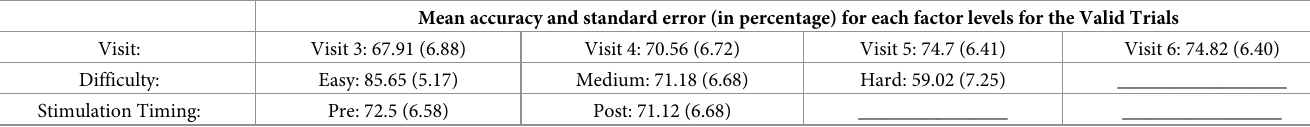
Table 4. Summary of mean accuracy and standard error for the significant main effects. Mean accuracy and standard error (in percentage) for each factor levels for the Valid Trials